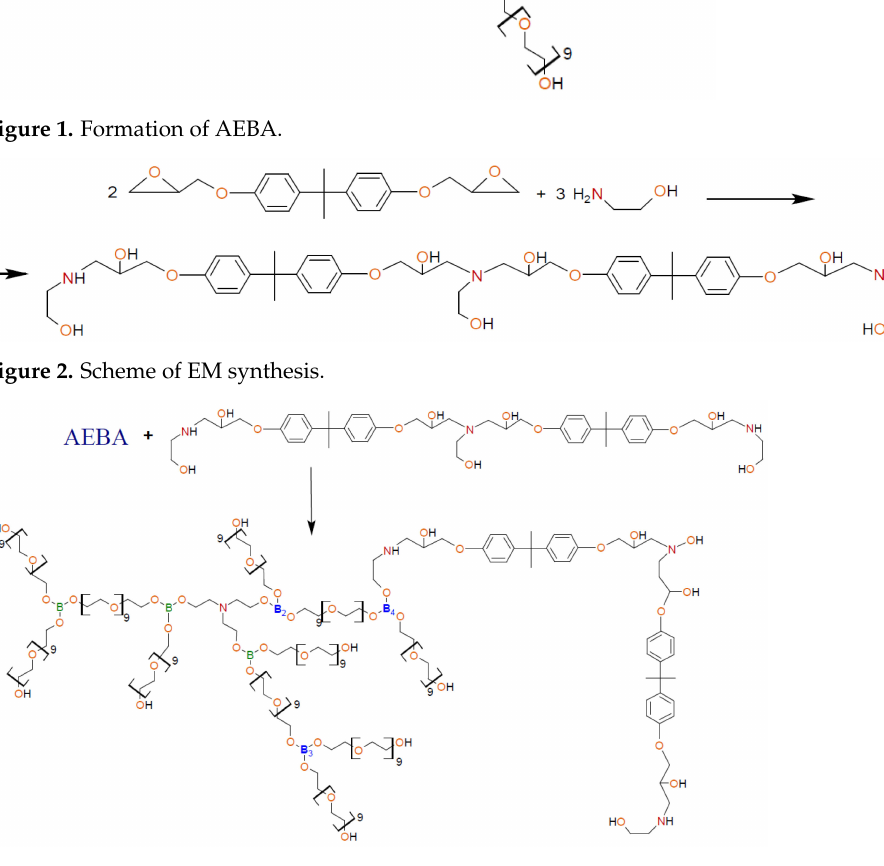
Figure 3. Synthesis of